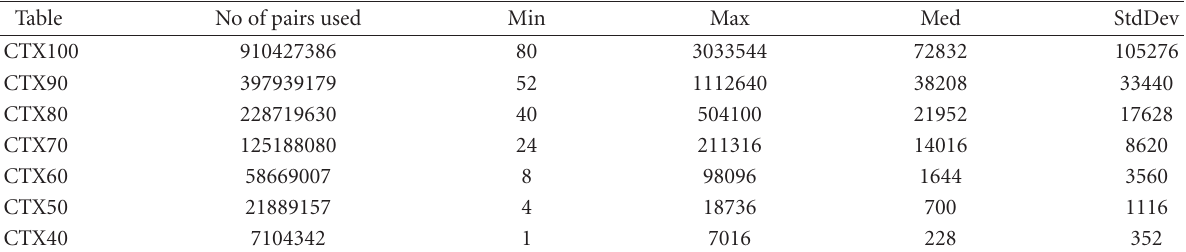
Table 3. The robustness of contextual tables. The range, median, and standard deviation for the number of examples drawn on per substitution score.